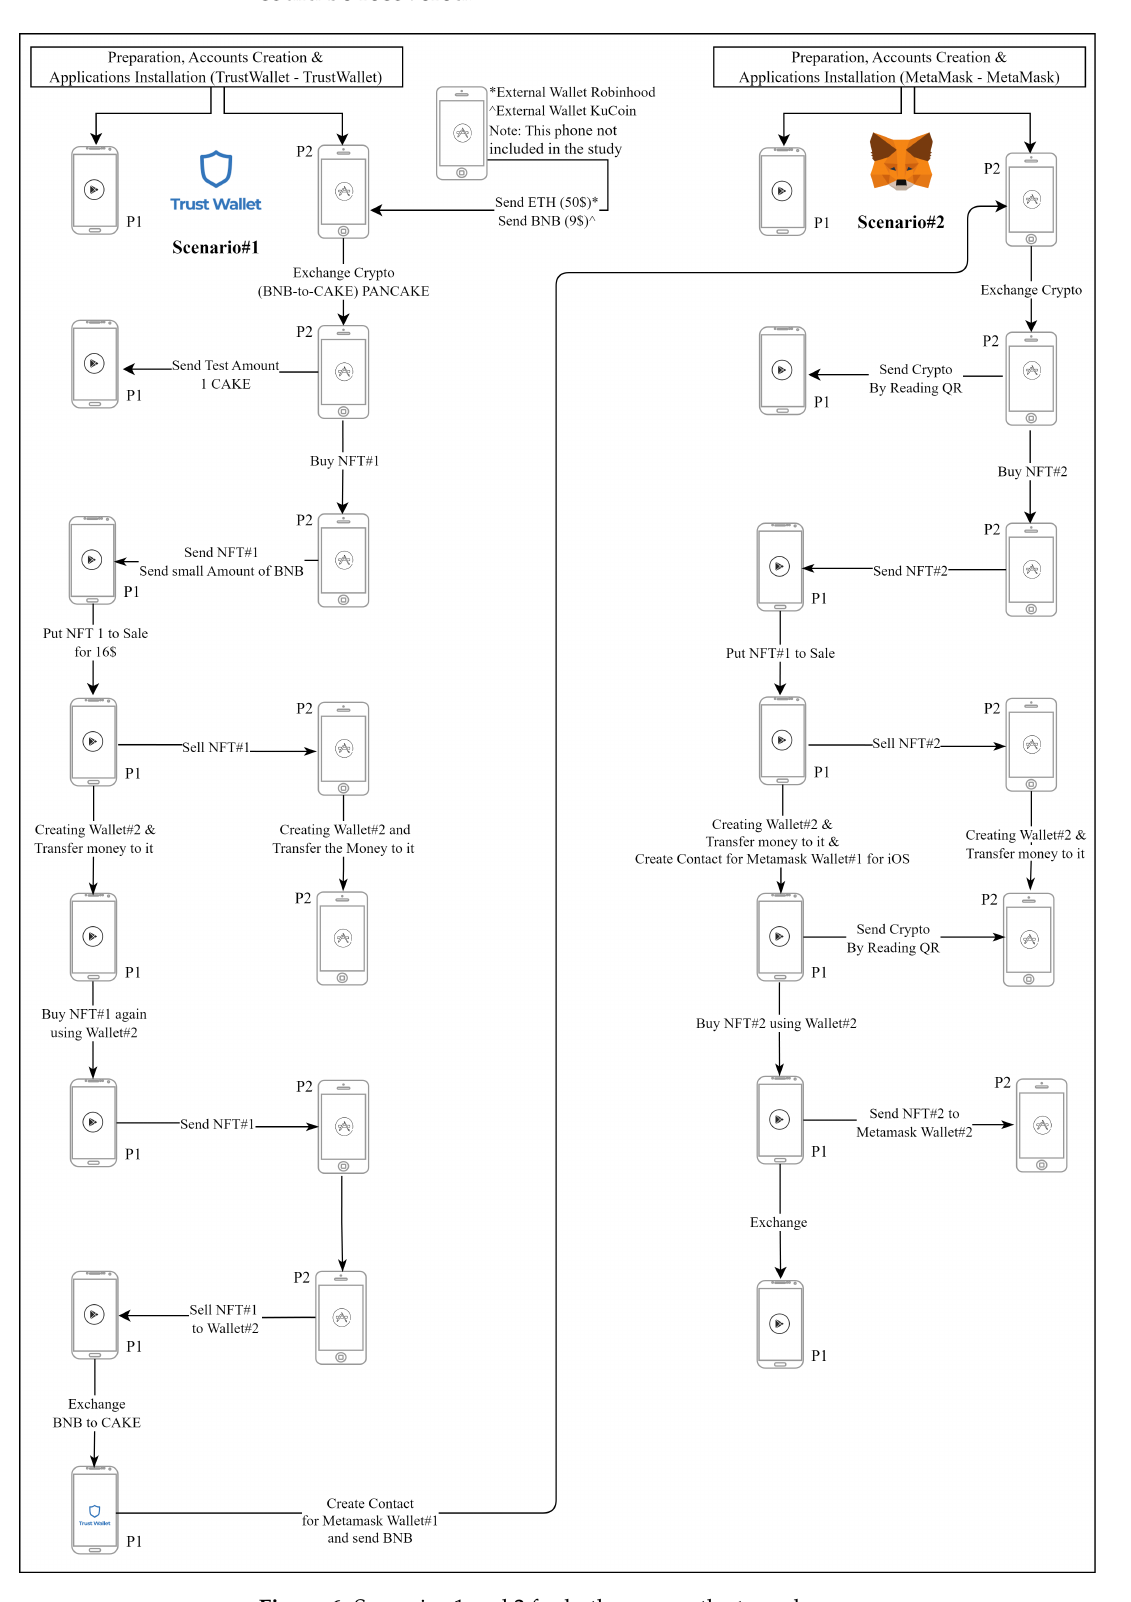
Figure 6. Scenarios 1 and 2 for both apps on the two